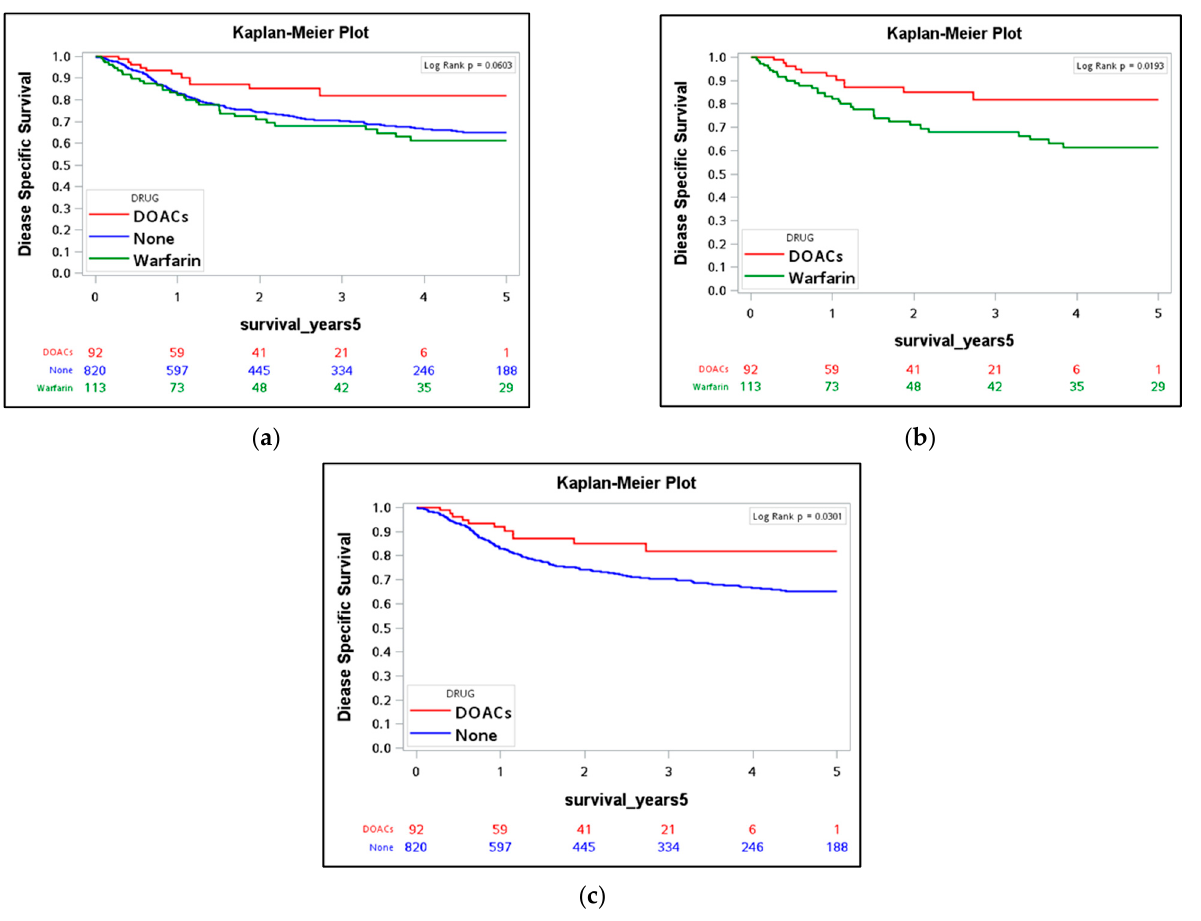
Figure 2. Kaplan–Meier survival curve of disease specific survival between (a ) DOACs users ( n = 92), warfarin users ( n = 113) and non-users ( n = 820); ( b ) DOACs users and warfarin users; ( c ) DOACs users and non-users.